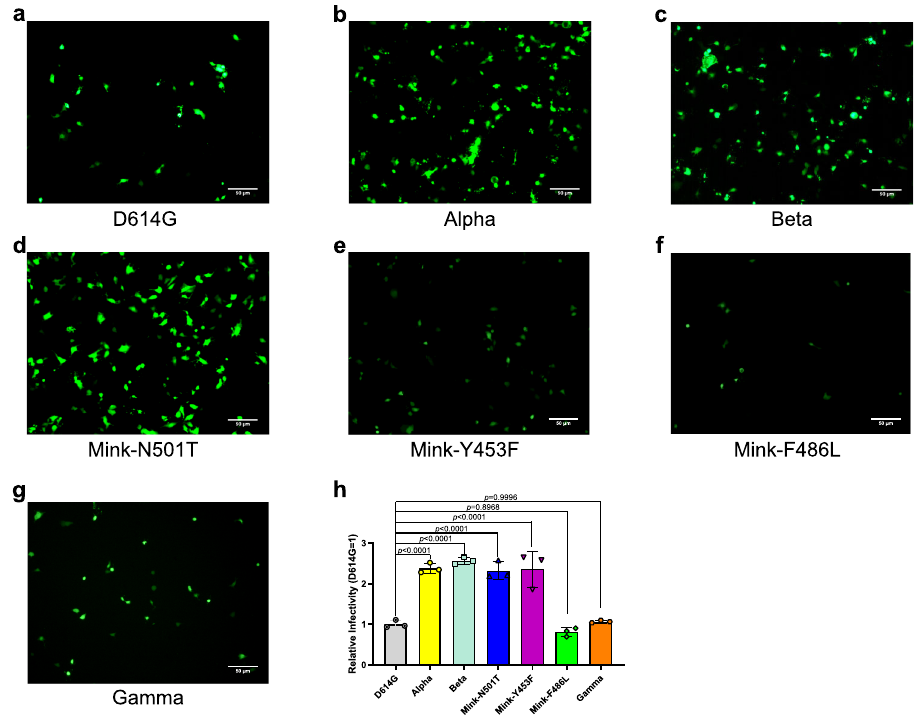
Fig. 4 Entry of SARS-CoV-2 variant pseudoviruses into Huh7 cells. a – g The SARS-CoV-2 D614G ( a ), Alpha ( b ), Beta ( c ), Mink-N501T ( d ), Mink-Y453F ( e ), Mink-F486L ( f ), and Gamma ( g ) pseudoviruses ’ entry into Huh7 cells as evidenced by GFP expression in transduced cells. The representative results from three experiments are shown. h The GFP-positive cells were quanti fi ed using FACS and representative results from three experiments are shown. The values indicate the mean of the three experiments and the bar suggest the SD. Relative infectivity was normalized against that of the D614G pseudovirus. Statistical signi fi cance was analyzed using a one-way ANOVA with Tukey ’ s multiple comparison test for multiple groups.